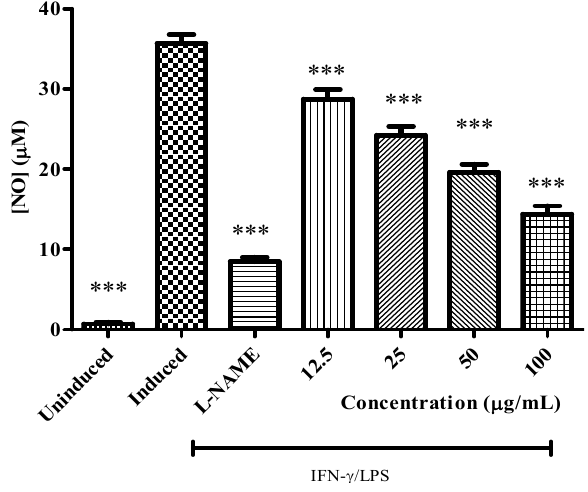
Figure 6. Effect of C. aurantium extracts at various concentration on the production of NO by LPS/IFN- γ stimulated RAW 264.7 cells. Each bar represents the mean ± standard error of mean from three independent experiments. *** p < 0.0001 indicates a significant difference from the LPS/IFN- γ stimulated cells analyzed by using the Dunnett’s Comparison Test.